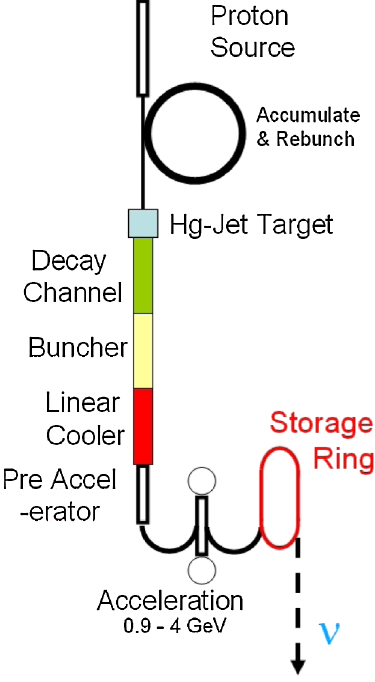
FIG. 1. (Color) Schematic for a 4 GeV neutrino factory.